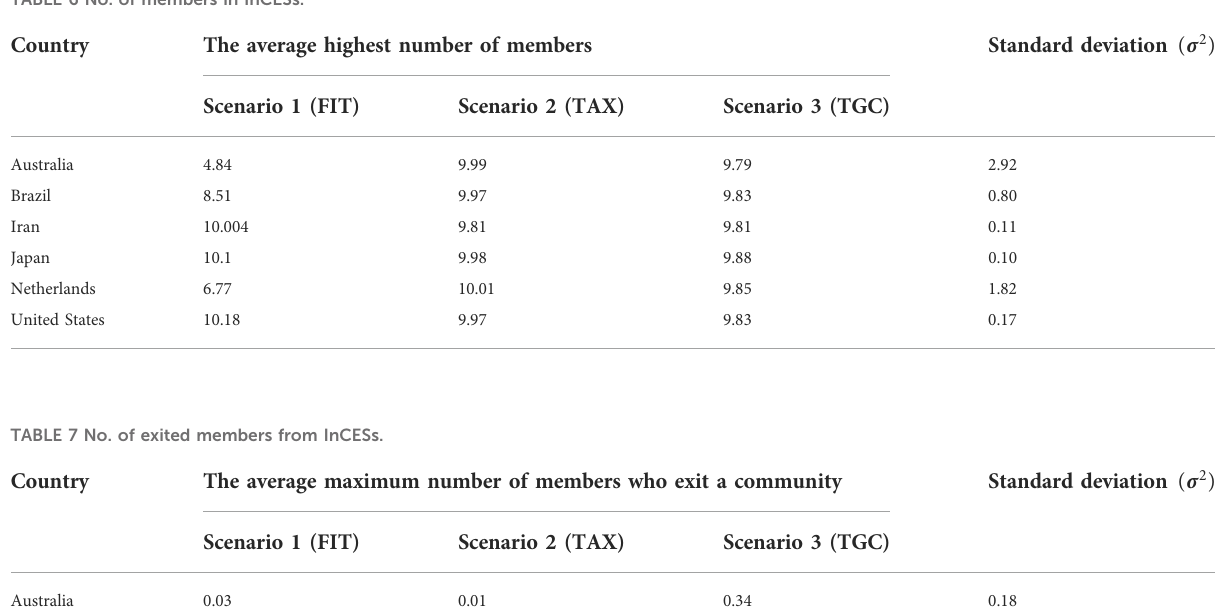
TABLE 6 No. of members in InCESs. Country The average highest number of